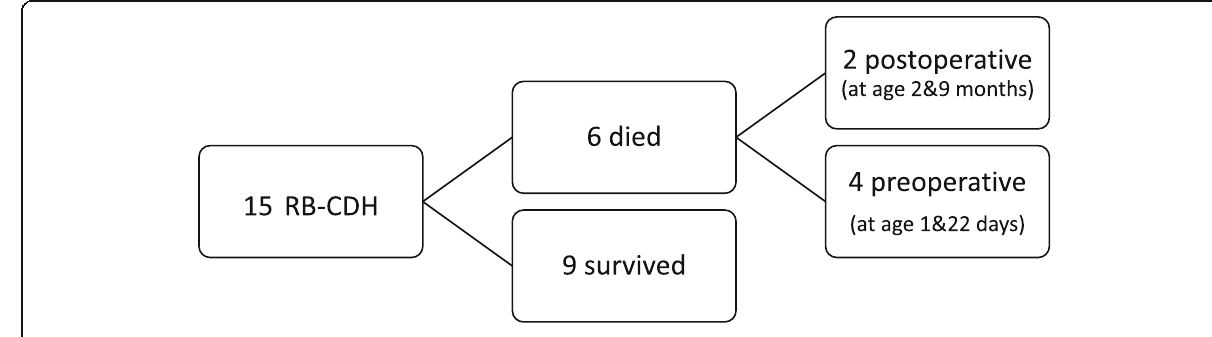
Fig. 1 Flow diagram of infants with